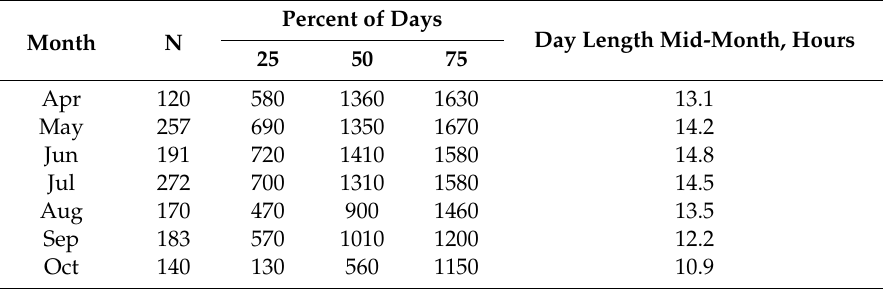
Table 4. Cumulative probability distribution of the photosynthetically active ration (PAR, µ mol of photons m − 2 s − 2 ) at solar noon in West Virginia being at or below the indicated level (based on 1333 measurements over two years, rounded to the nearest 10